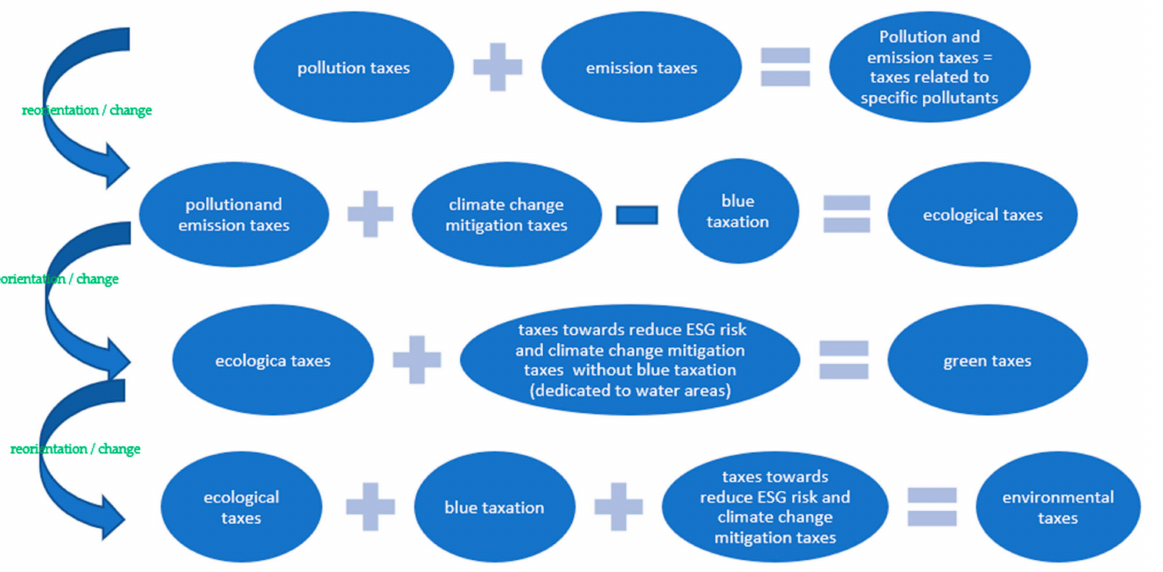
Figure 1. The meaning of environmental taxes. Source: own